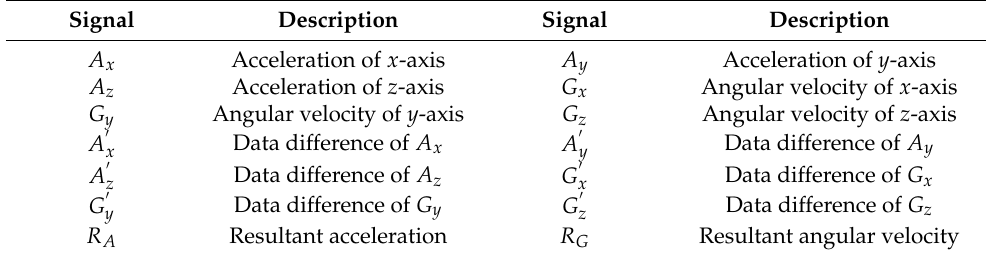
Table 2. Description of 14 signals of HAR.